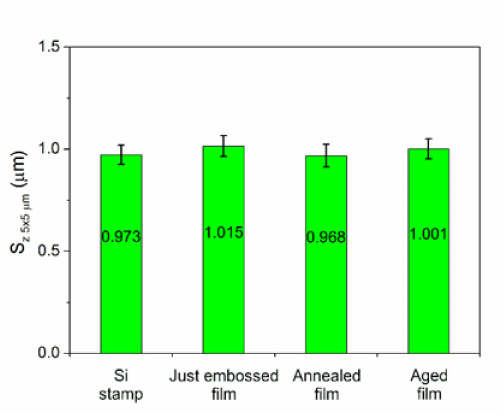
Figure 10. Maximum peak to valley heights in 5 µ m × 5 µ m areas of the Si stamps and textured thiol-ene films embossed at 100 ◦ C under 30 MPa for 1 h.